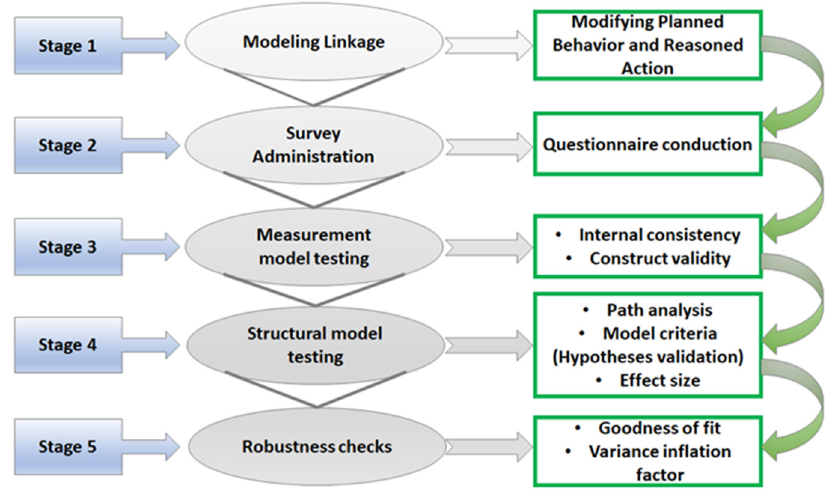
Figure 2. Schematic outline of the research methodology. Source : Authors’ elaboration.